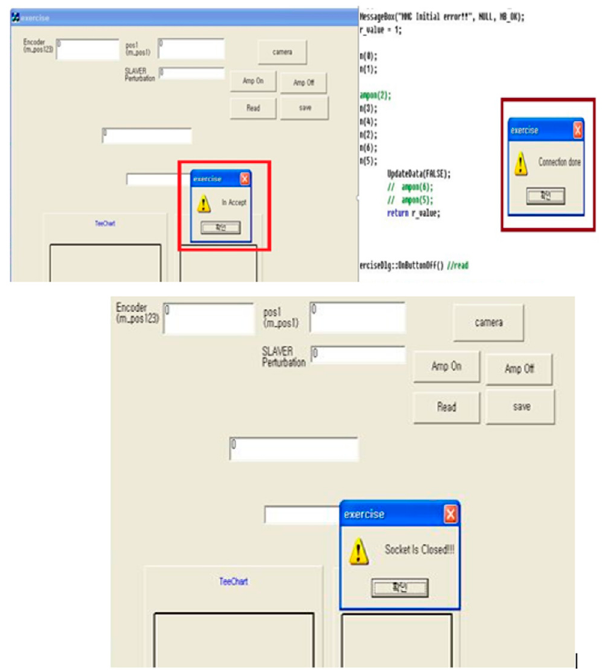
Figure 4. Client server (master and slave) connection confirmation status.